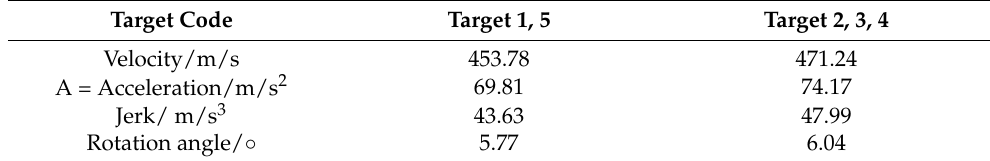
Table 2. Parameters of group targets.